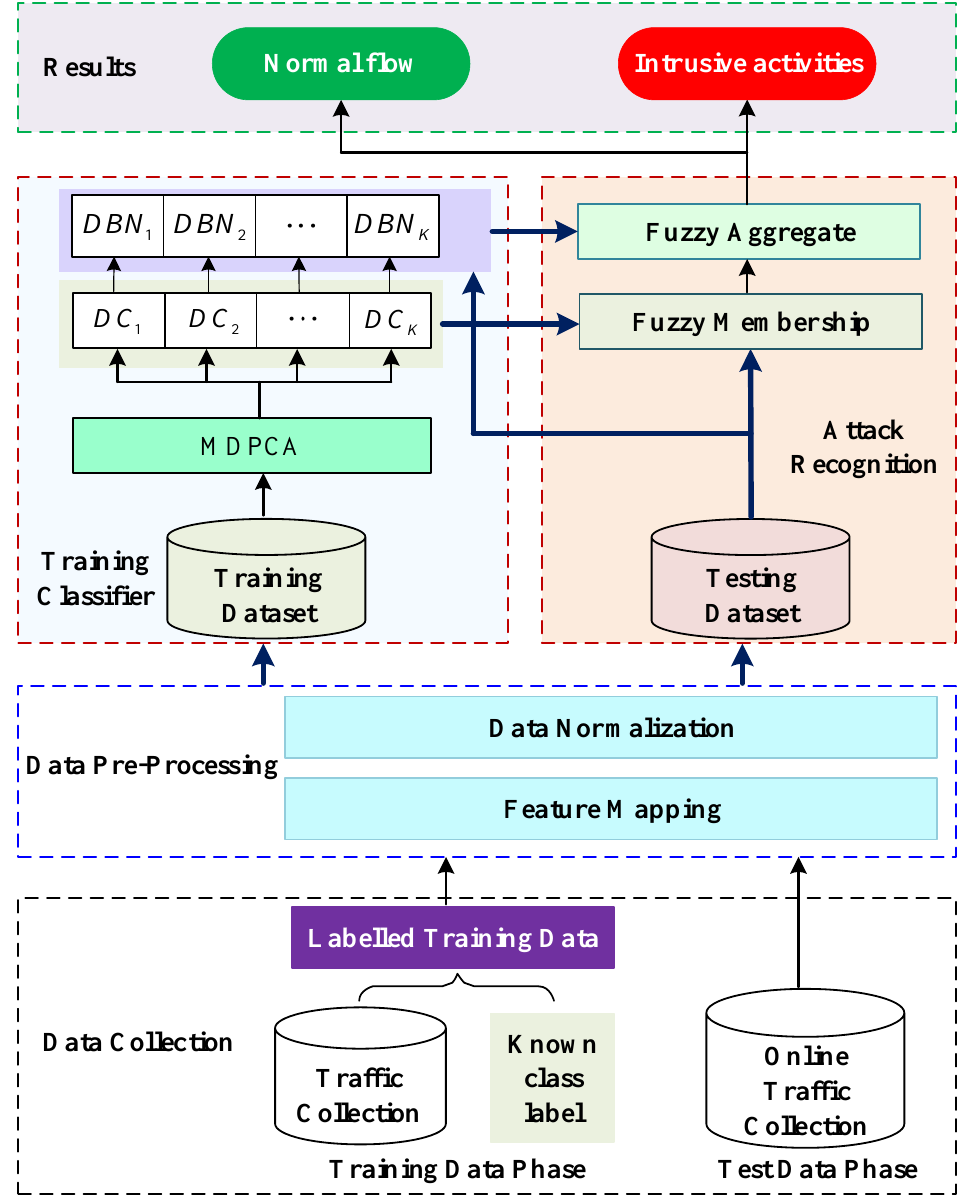
Figure 4. The framework of the proposed hybrid